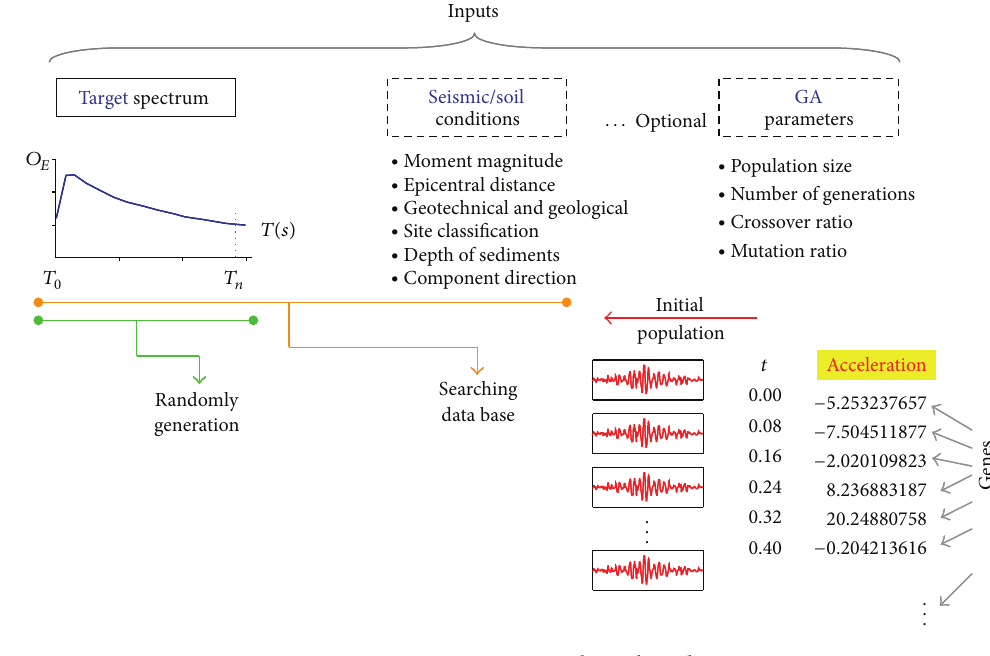
Figure 16: Genetic Generator: working phase diagram.